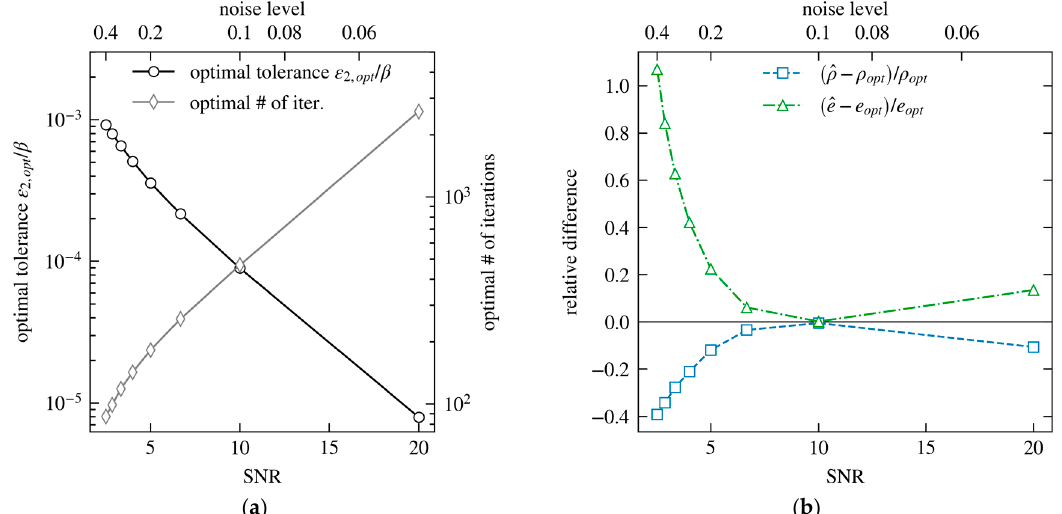
Figure 6. ( a ) Variation of tolerance (cid:15) 2 / β and number of iterations of the ART algorithm at the point of minimum reconstruction error e opt (compare Figure 5b) as a function of noise level or signal-to-noise ratio (SNR). ( b ) Relative change between the optimum error e opt or optimum correlation coe ffi cient ρ opt and their values (ˆ e and ˆ ρ ) for a fixed termination criterion of (cid:15) 2 / β = 10 − 4 .